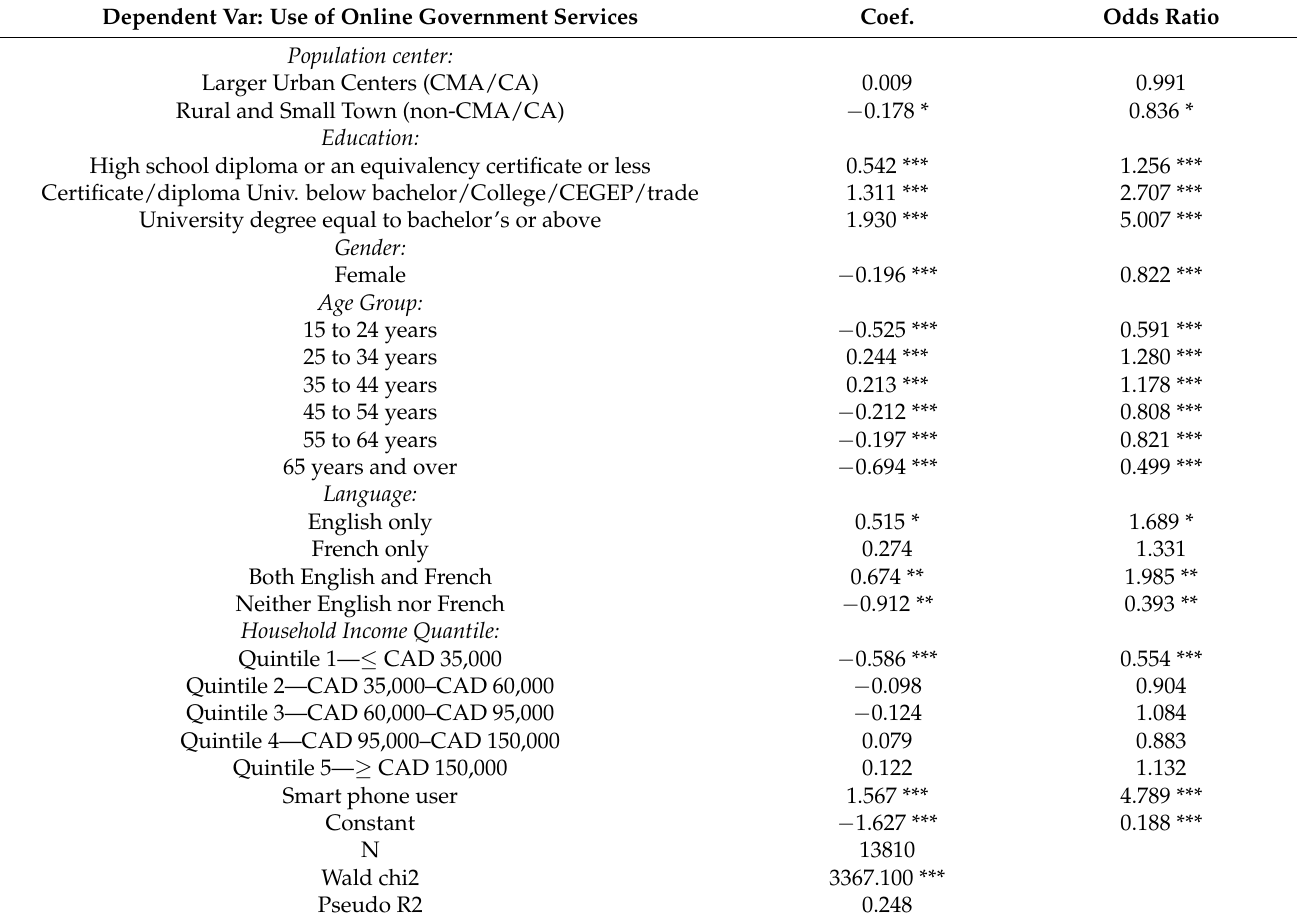
Table 2. Determinants of access to government